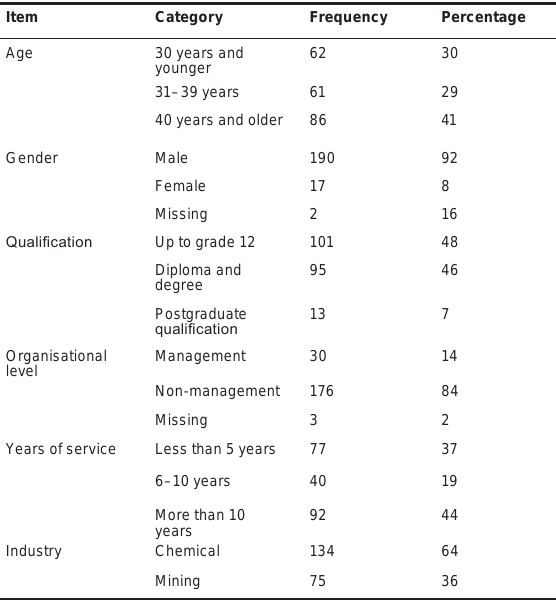
TABLE 1 Characteristics of the